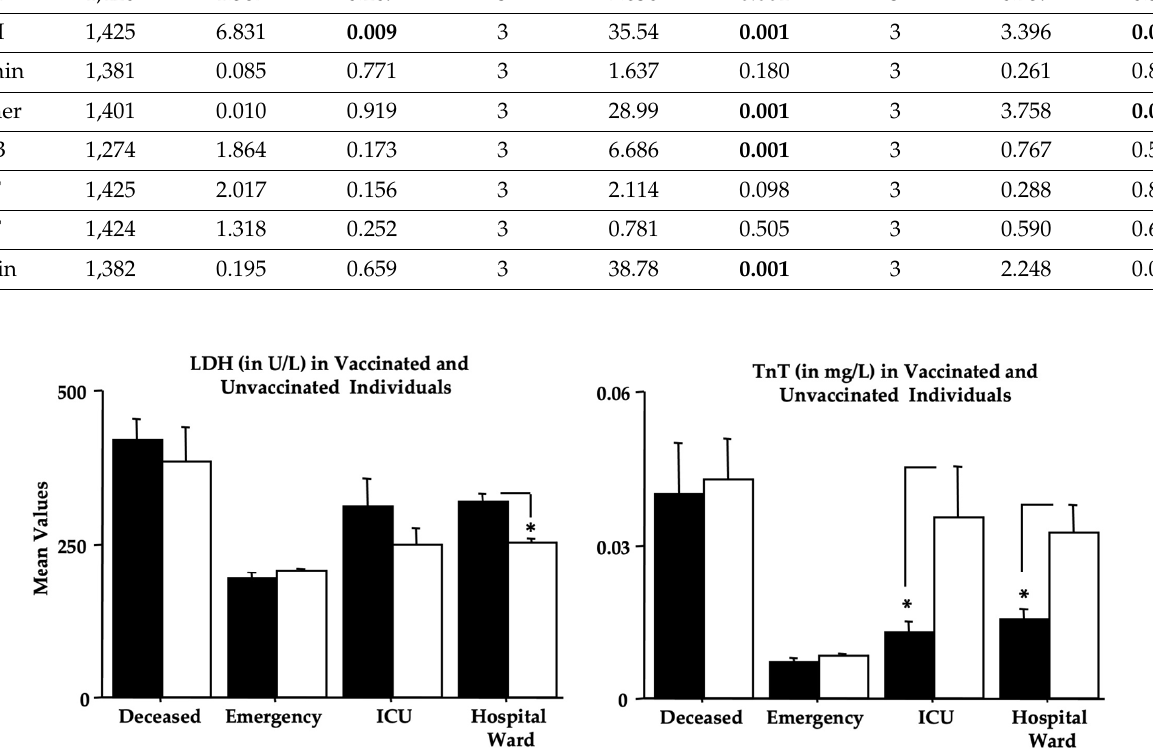
Figure 7. Ferritin in recruited women and men (and relative reference ranges). The error bars indi ‐ cate the pooled standard error means (SEM) derived from the appropriate error mean square in the ANOVA. The asterisks (* p < 0.05) indicate post hoc differences between groups.